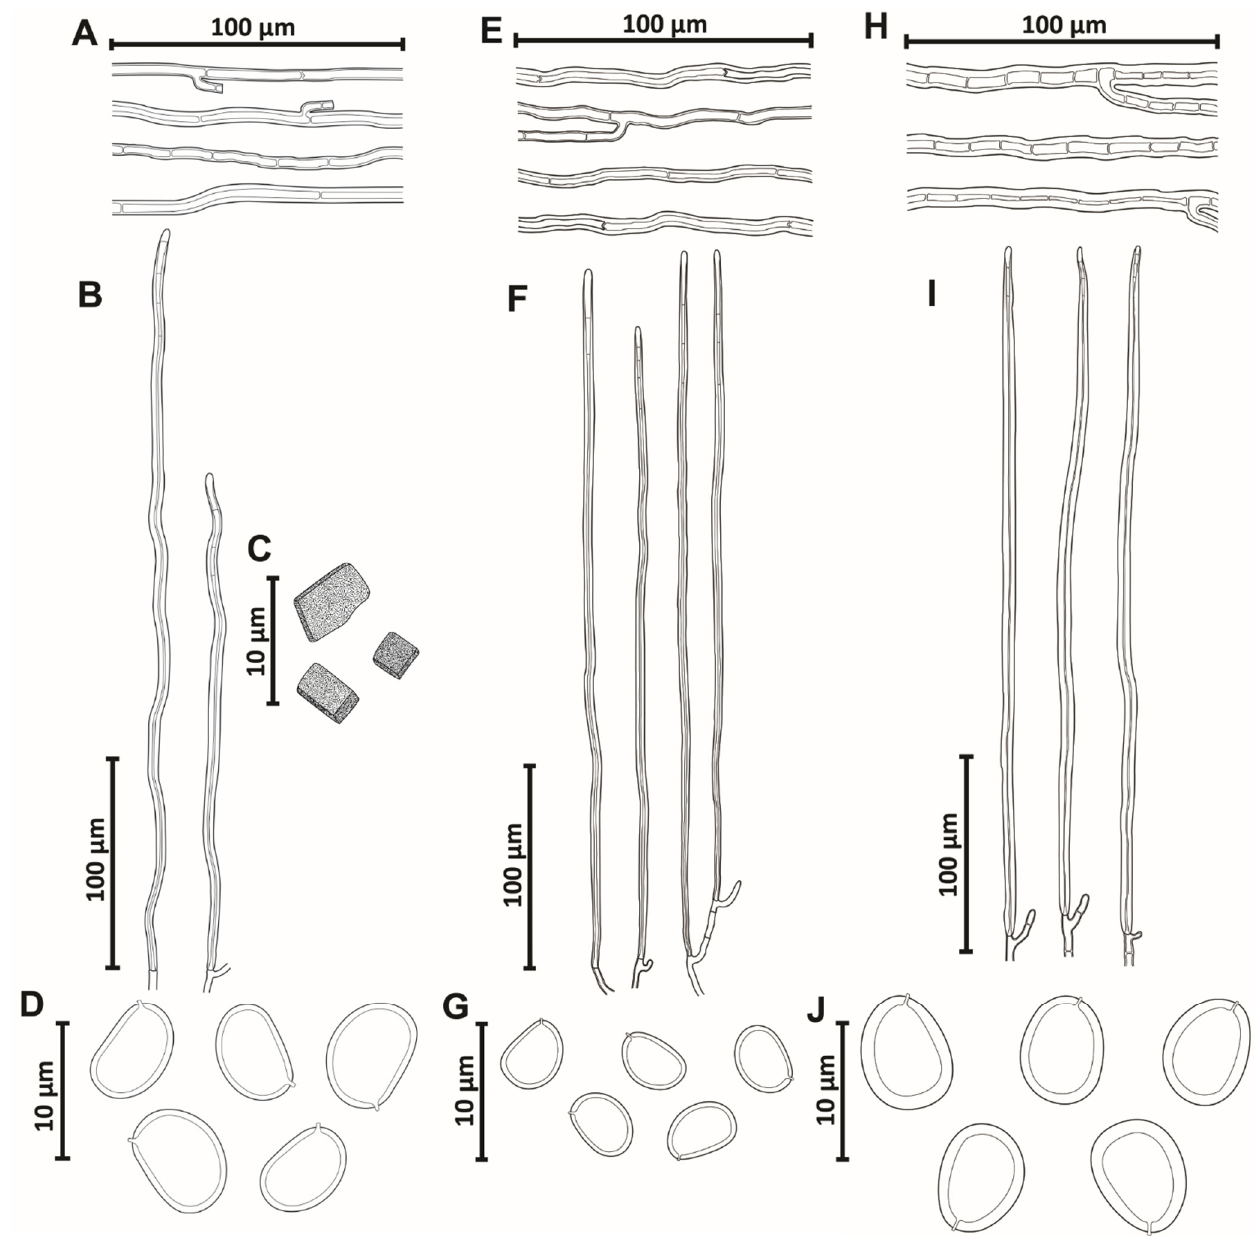
Figure 4. Micromorphological features of Phellinotus badius , P . magnoporatus , and P . resinaceus . ( A – D ) Phellinotus badius . ( A ) Generative hyphae of the context; ( B ) skeletal hyphae of the tubes; ( C ) basidiospores; ( D ) quadrangular crystals of the tubes. ( E – G ) Phellinotus magnoporatus . ( E ) Generative hyphae of the context; ( F ) skeletal hyphae of the tubes; ( G ) basidiospores. ( H – J ) Phellinotus resinaceus . ( H ) generative hyphae of the context; ( I ) skeletal hyphae of the tubes; ( J ) basidiospores. ≡ Coriolopsis badia (Berk. ex Cooke) Murrill, Bulletin of the Torrey Botanical Club 34: 466 (1907).